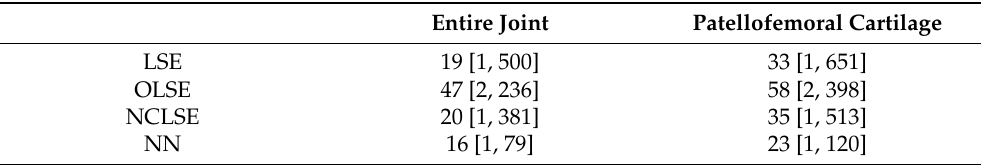
Table 3. Median absolute-valued relative quantification errors in the quantification of T2 relaxation times [%] as a function of fitting method. Data are given as medians [2.5th percentile, 97.5th percentile]. Please refer to Figure 1 for an explanation of the abbreviations.